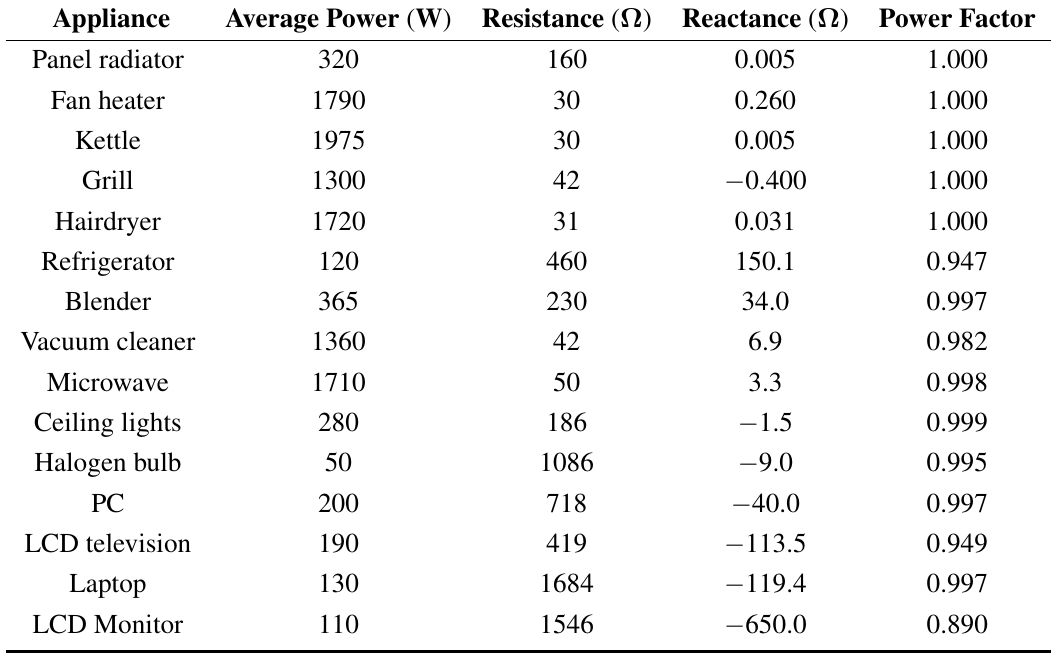
Table 2. Properties of the set of test appliances, as measured by the Allegro PM3000a Universal Power Analyser at 50 Hz.